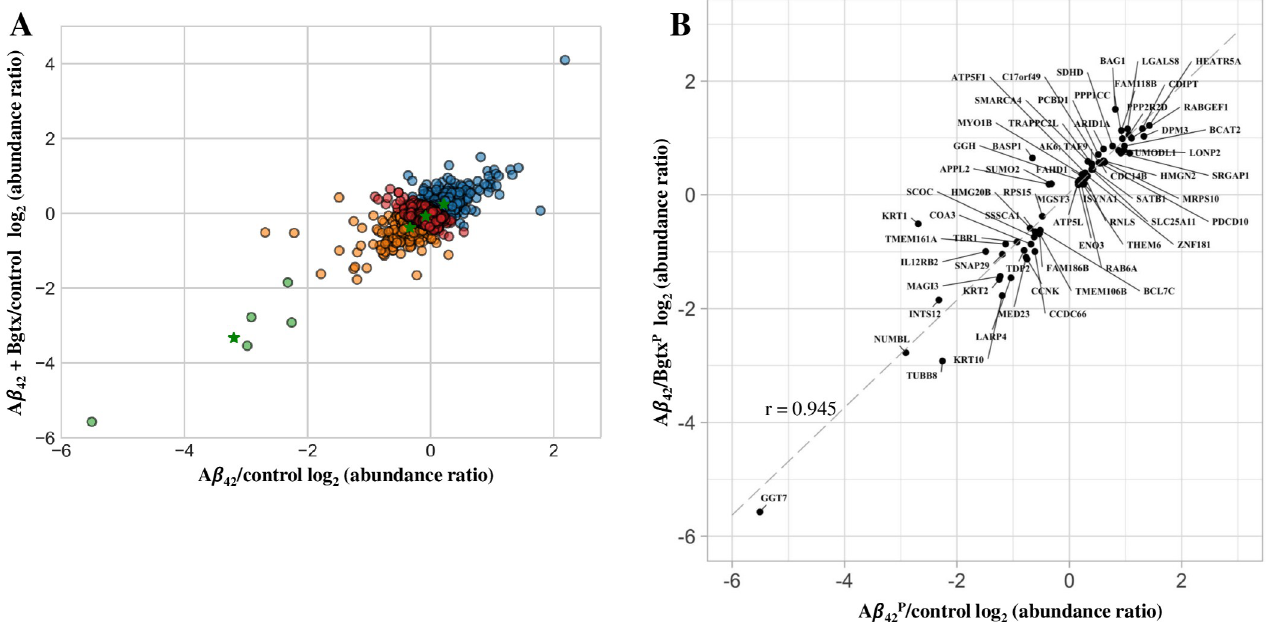
Fig 4. Clustering and correlation analysis of the proteomes. A) A K-means cluster analysis of detected proteins across both A β 42 and A β 42 + Bgtx treatment conditions. The analysis indicates 4 cluster means (green stars). B) Scatterplot and correlation analysis of the log 2 transformed abundance ratio measures for individual proteins within A β 42P and A β 42 /Bgtx P .